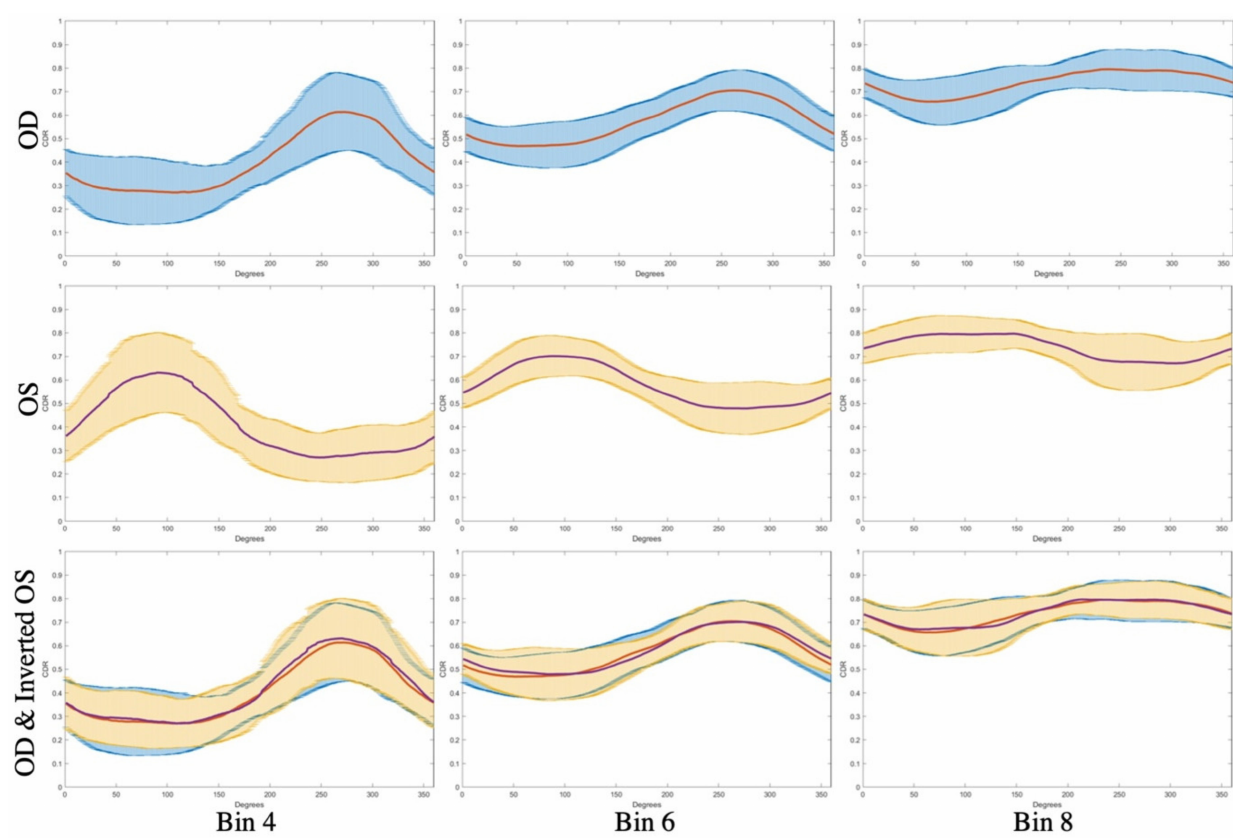
Figure 3. Mean (orange and purple) and standard deviation (blue and yellow) of the half cut-through CDR at each degree location of stereo disc photos for OD (top row) and OS (middle row) eyes from patients in Bins 4, 6, and 8. The bottom row shows the correspondence between the OD and OS half-cut-through pattern when the OS eyes are inverted horizontally. The full cut-throughs showed a similar pattern, with the highest mean CDR observed at the horizontal bisector (i.e., 90 ◦ and 270 ◦ ) and the lowest at the vertical bisector (0 ◦